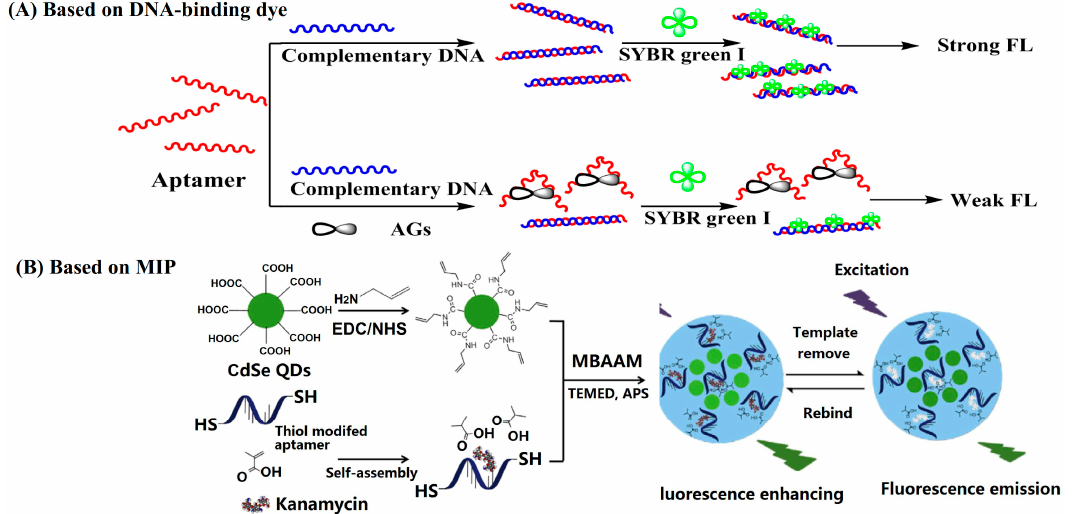
Figure 3. Typical turn-off fluorescent (FL) assays for the detection of AGs (reprinted with permission from [29] Copyright (2018) Elsevier).